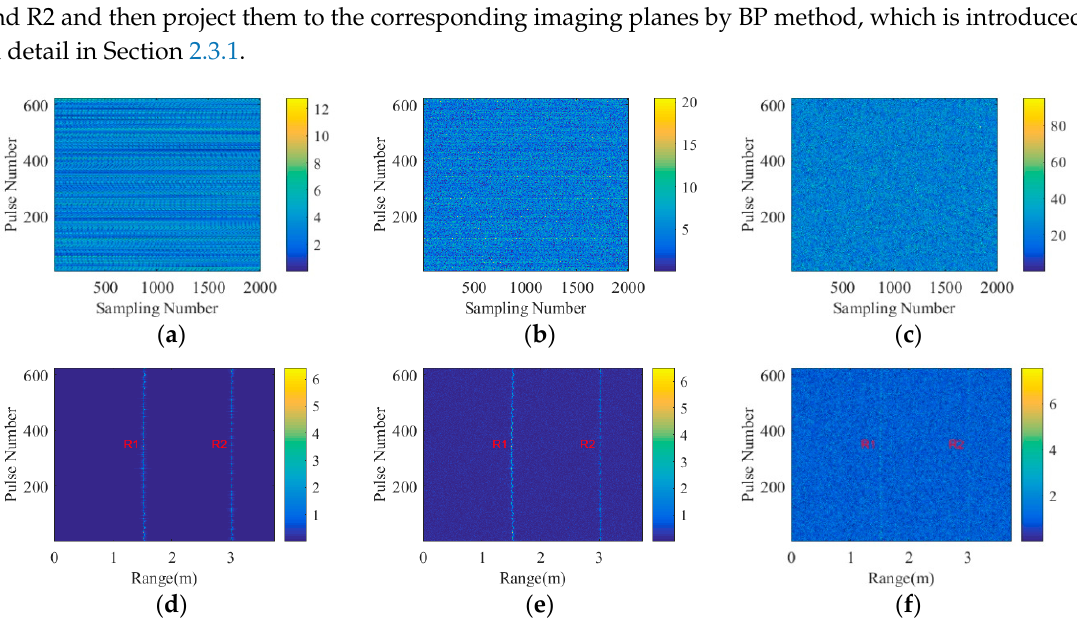
Figure 6. Original back signal under ( a ) 30 dB, ( b ) 0 dB and ( c ) − 30 dB, respectively. Range profile under ( d ) 30 dB, ( e ) 0 dB and ( f ) − 30 dB, separately. Herein, R1 and R2 describe the imaging planes 1 and 2 at 1.5m and 3m, respectively.